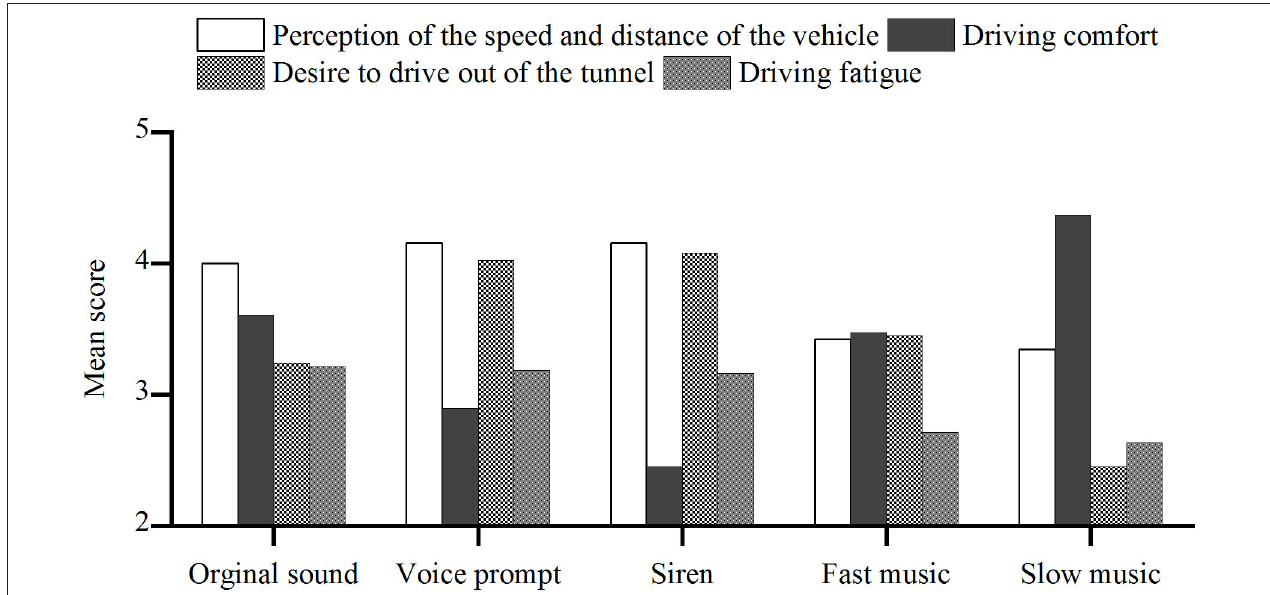
FIGURE 7 | Mean values of the subjective opinions on driving behavior under different sound